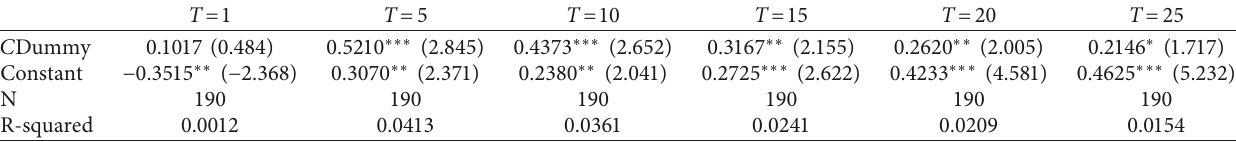
Table 4: Regression result of model (3): excessive trading volume and registered place of listed company. T � 1